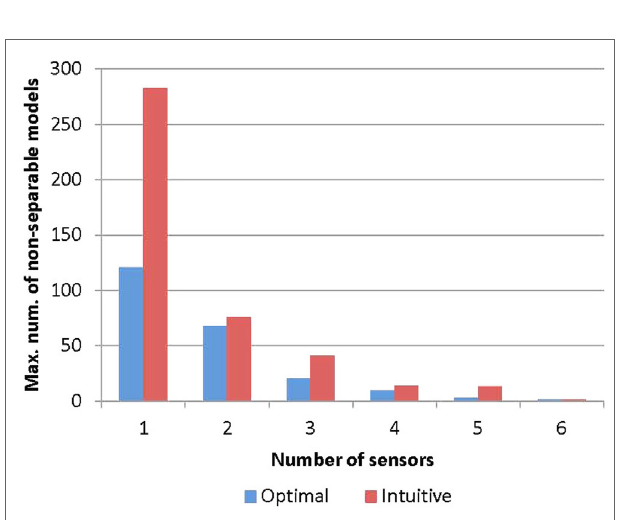
FigUre 7 | Maximum number of non-separable models for the two sensor placement methods